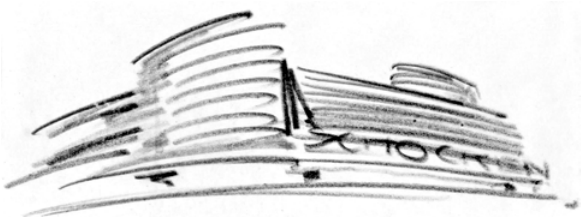
fig. 15. Sketch of Schocken Department Stores, 1926–27 (fragment). © Bildarchiv Preußischer Kulturbesitz (BPK). Note: Mendelsohn transfers the intensity of the perceived motion of linear architectural elements to the components of a